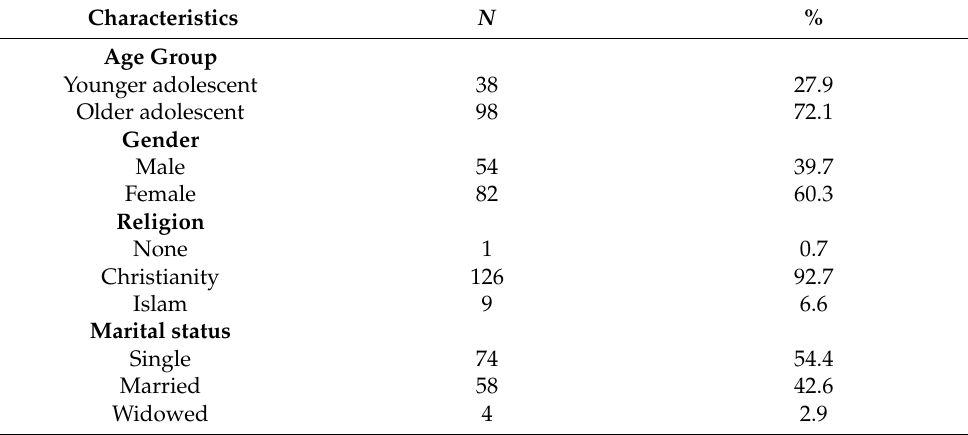
Table 1. Sociodemographic characteristics ( N =